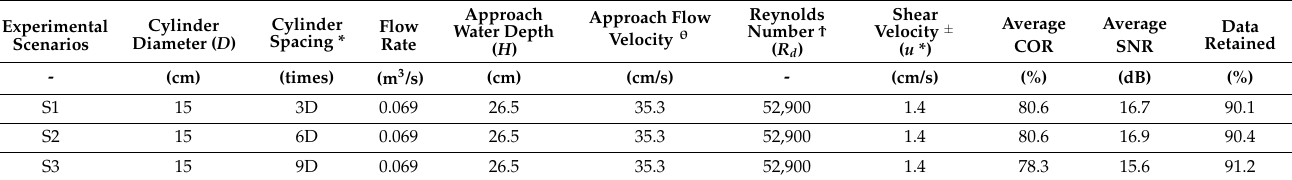
± The Reynolds shear stress method was applied to estimate u * using measured Reynolds shear stress very close to the bed (lower 10% depth). Ϯ Reynolds number is based on the diameter of the cylinder. * Spacing is in center to center. θ Depth- averaged approach flow velocity magnitude.